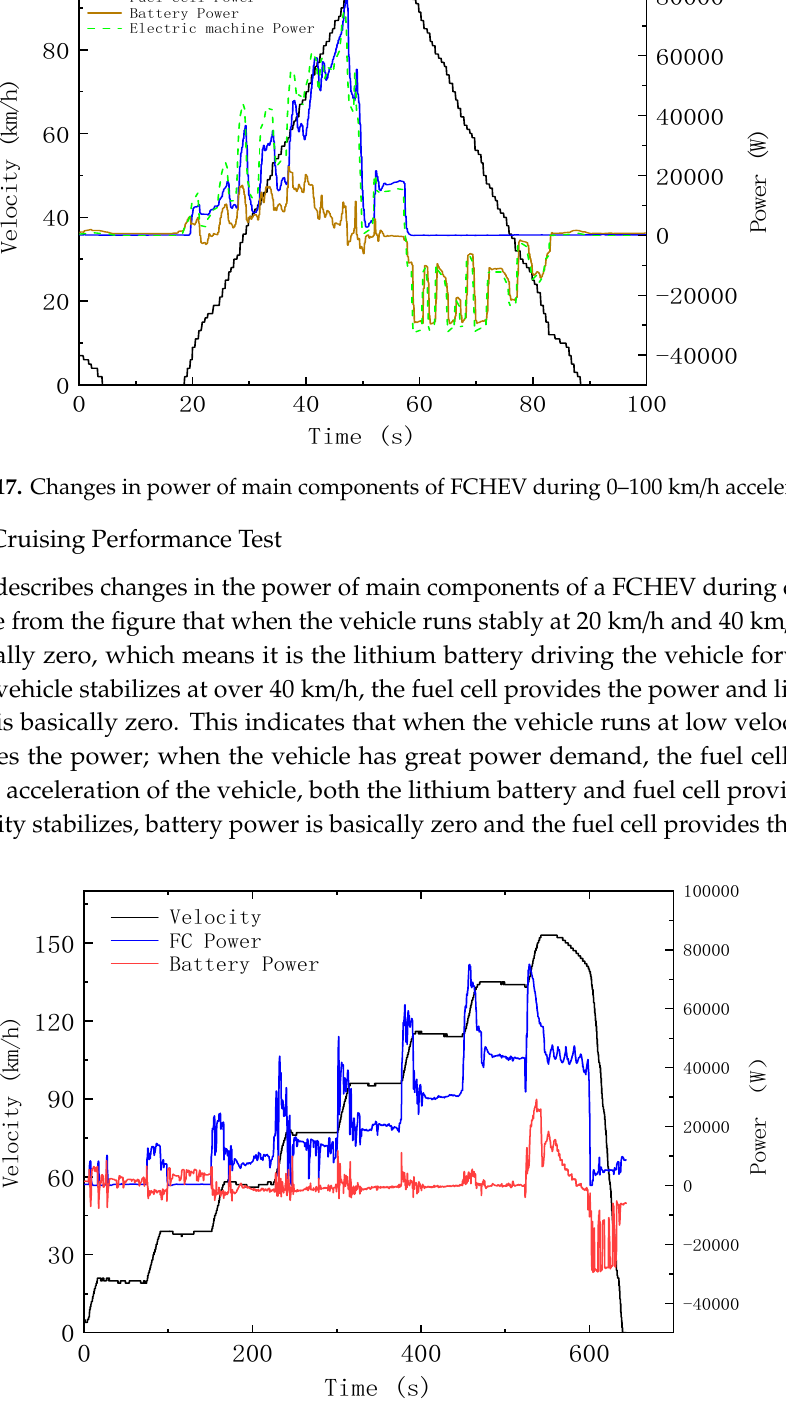
Figure 18. Changes in power of fuel cell and lithium battery of FCHEV in cruising mode.